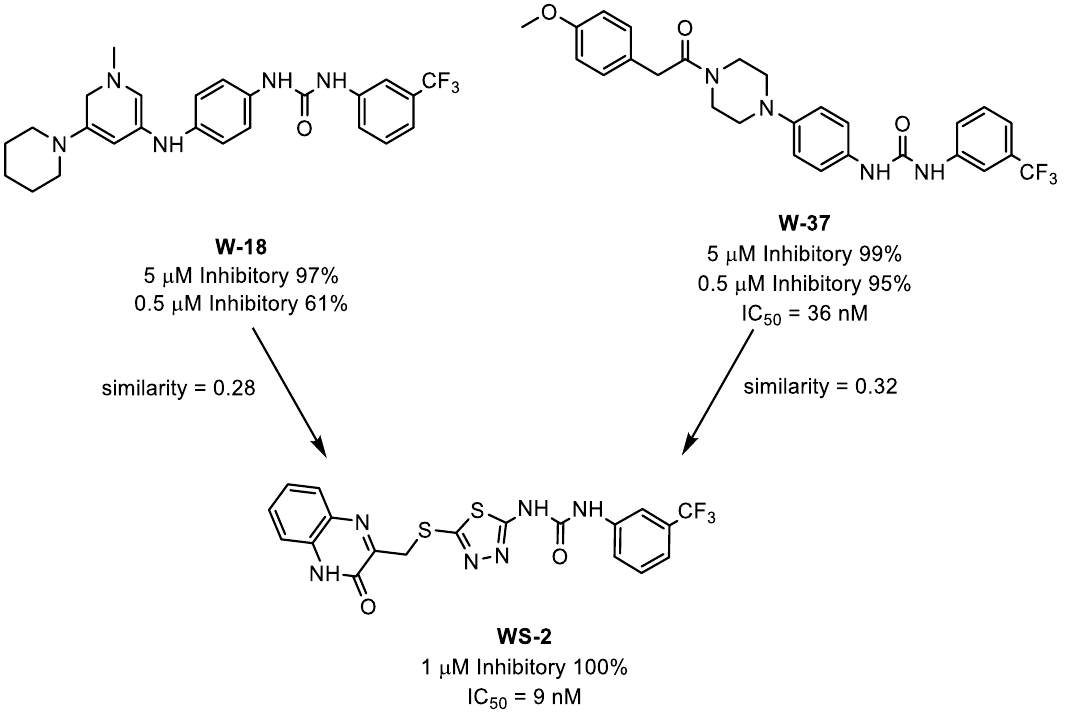
Figure 7. Discovery of the CDK8 inhibitor WS-2 from W-18 and W-37 using similarity search [228].